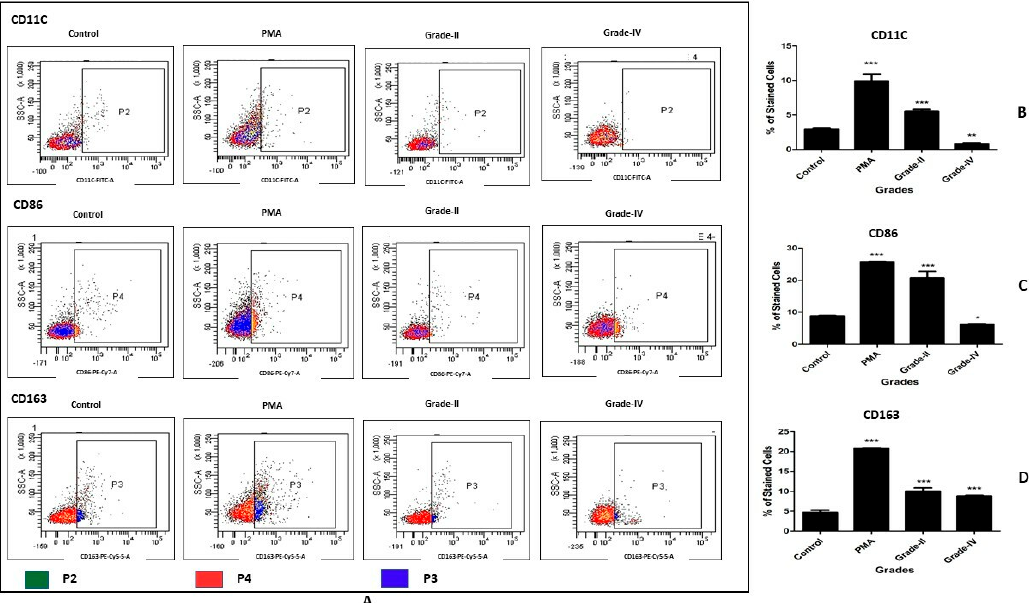
Figure 4. In vitro cell differentiation assay on PBMC-derived CD14+ cells. PBMC-derived CD14+ cells were induced with SF of KL grade II and IV for 48 h; the status of the newly differentiated cells was evaluated with the cell surface markers CD11C, CD86, and CD163. ( A ) shows representative scatterplots of the differentiated macrophages and their subsets; CD11C and CD86 are M1 markers, while CD163 is an M2 subtype marker; the gating was based on isotype control. ( B – D ) shows a grade-wise staining pattern of CD11C+, CD86+, and CD163+ cells; to create these bar graphs, the average percentage of each cell surface marker estimated from three SF samples of each KL grade was used (n = 6); the experiment was performed in triplicate and repeated three times. * p < 0.05, ** p < 0.01, *** p < 0.001, as compared to control.